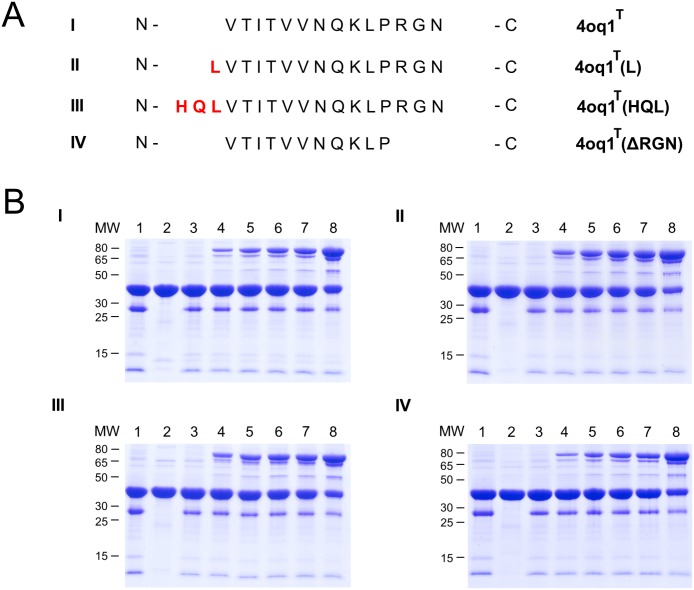
Comparative analysis of different 4oq1T-MBP variants.(A) Sequence alignment of different 4oq1T-MBP variants (I: 4oq1T wildtype (residues V246-N259), II: N-terminal L245 extension of 4oq1T, III: N-terminal H243-Q244-L245 extension of 4oq1T, IV: C-terminal R257-G258-N259 truncation of 4oq1T). (B) Comparative covalent intermolecular bond formation assay between different 4oq1T-MBP variants and mCherry-4oq1C (0h-24h). Purified 4oq1T variants and mCherry-4oq1C proteins were mixed each at 15 μM (final conc.) for 24h at 25°C with shaking at 500 rpm before boiling (10min, 95°C) and SDS-PAGE with Coomassie staining. Interaction I: mCherry-4oq1C + 4oq1T (wildtype), interaction II: mCherry-4oq1C + 4oq1T (L), interaction III: mCherry-4oq1C + 4oq1T (HQL), interaction IV: mCherry-4oq1C + 4oq1T (ΔRGN). (lane 1: mCherry-catcher input (30μM), lane 2: tag input (30μM), lane 3: 0h, lane 4: 1h, lane 5: 2h, lane 6: 3h, lane 7: 4h, lane 8: 24h). Same volume of samples were loaded. MW stands for molecular weight (kDa).